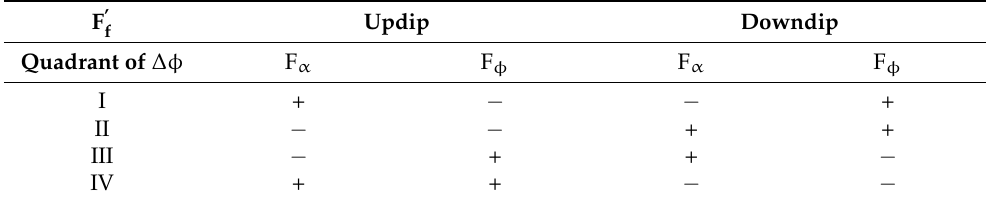
Table 2. Relationship between symbols of F α and F φ and their quadrants. F ’ f